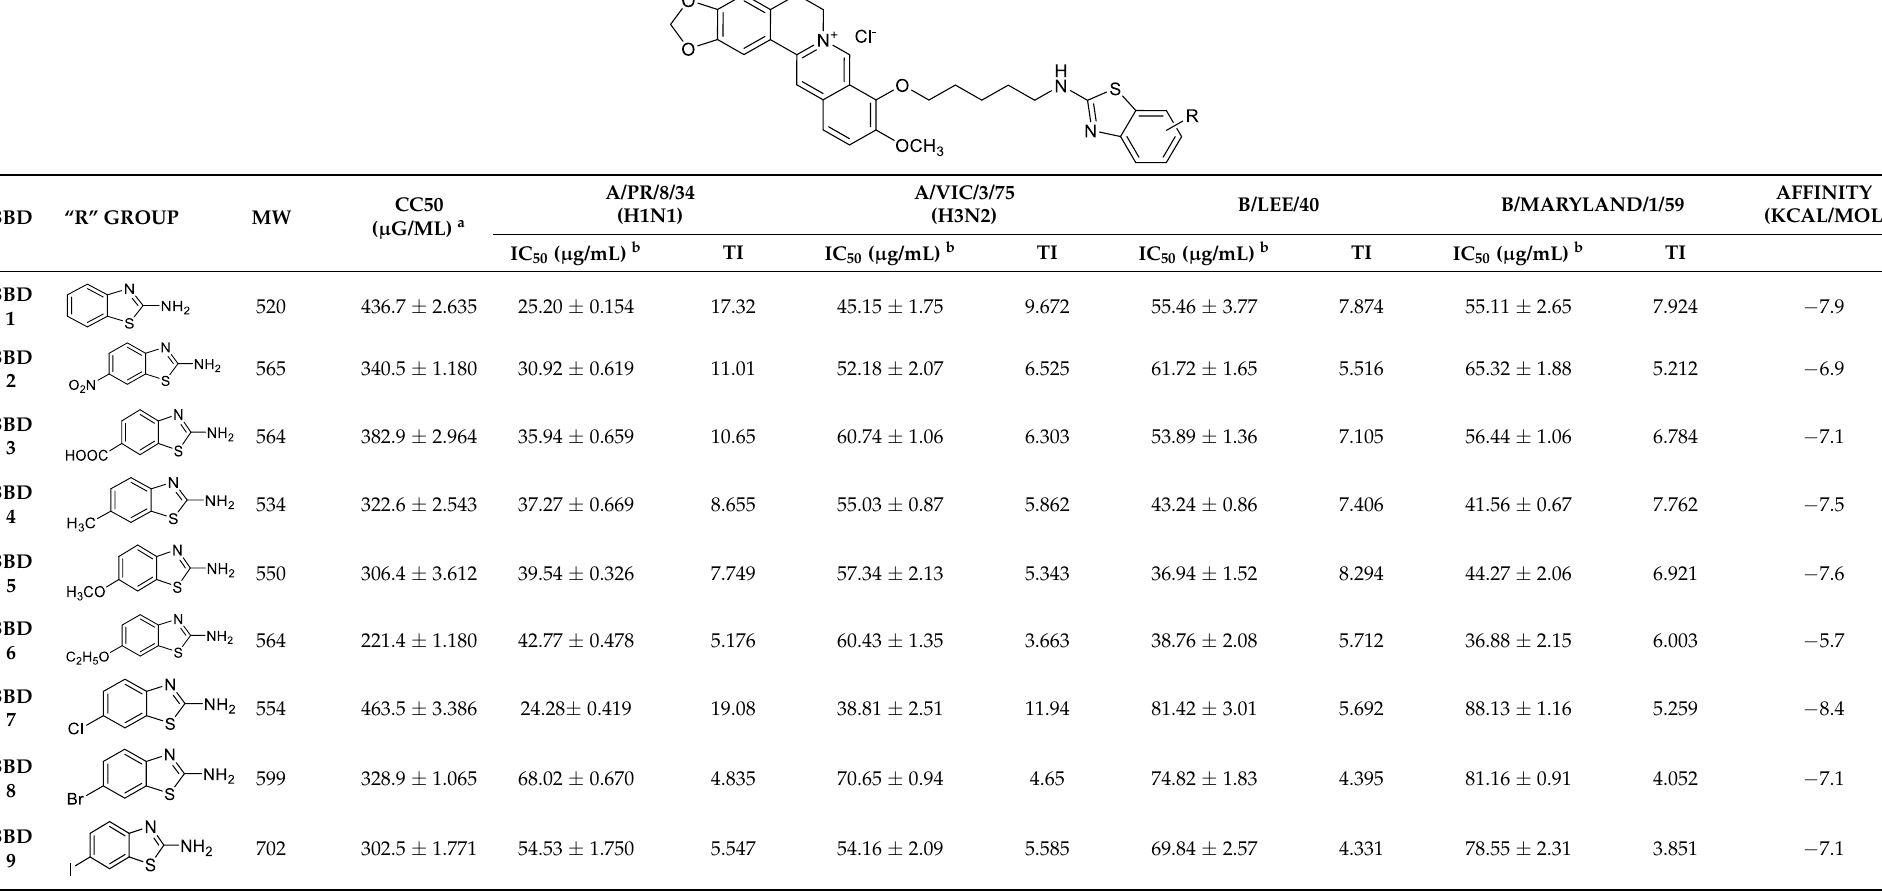
Table 1. In vitro optimization of berberine–benzothiazole-based inhibitors.